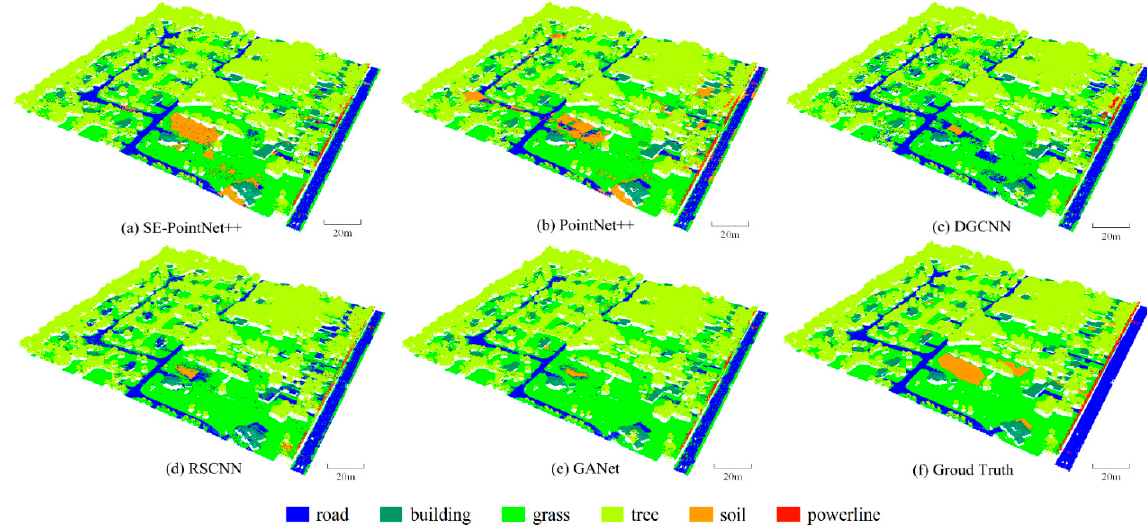
Figure 8. Illustration of the comparative point cloud classification results. ( a ) SE-PointNet++, ( b ) PointNet++, ( c ) DGCNN, ( d ) RSCNN, ( e ) GACNet and ( f ) Ground truth.